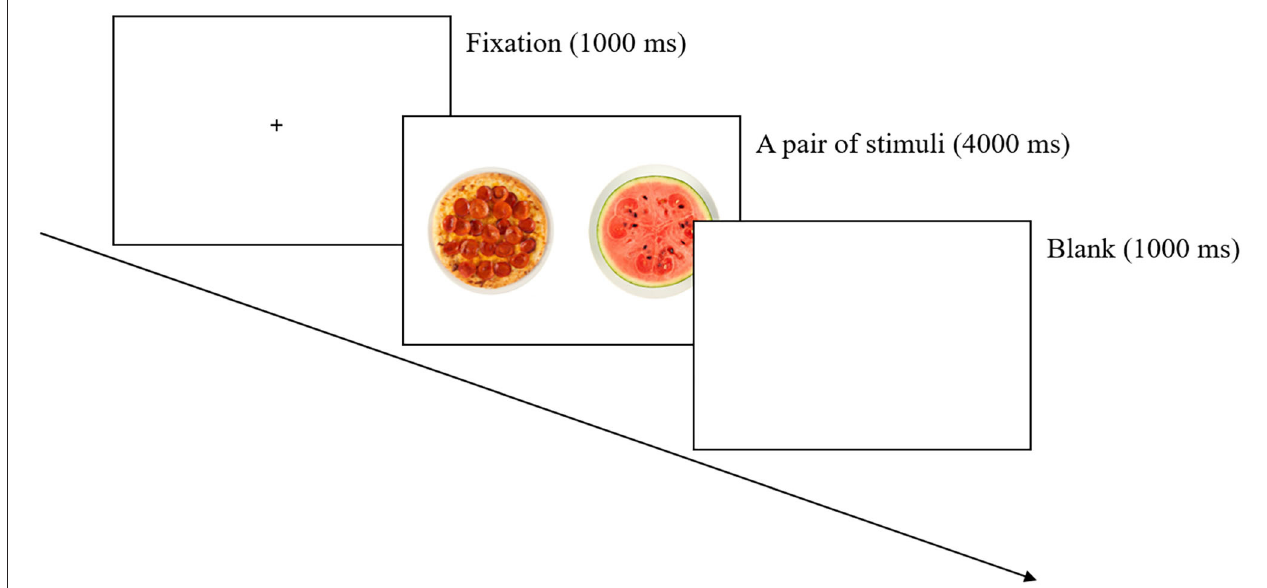
FIGURE 1 | Procedure for the free-viewing